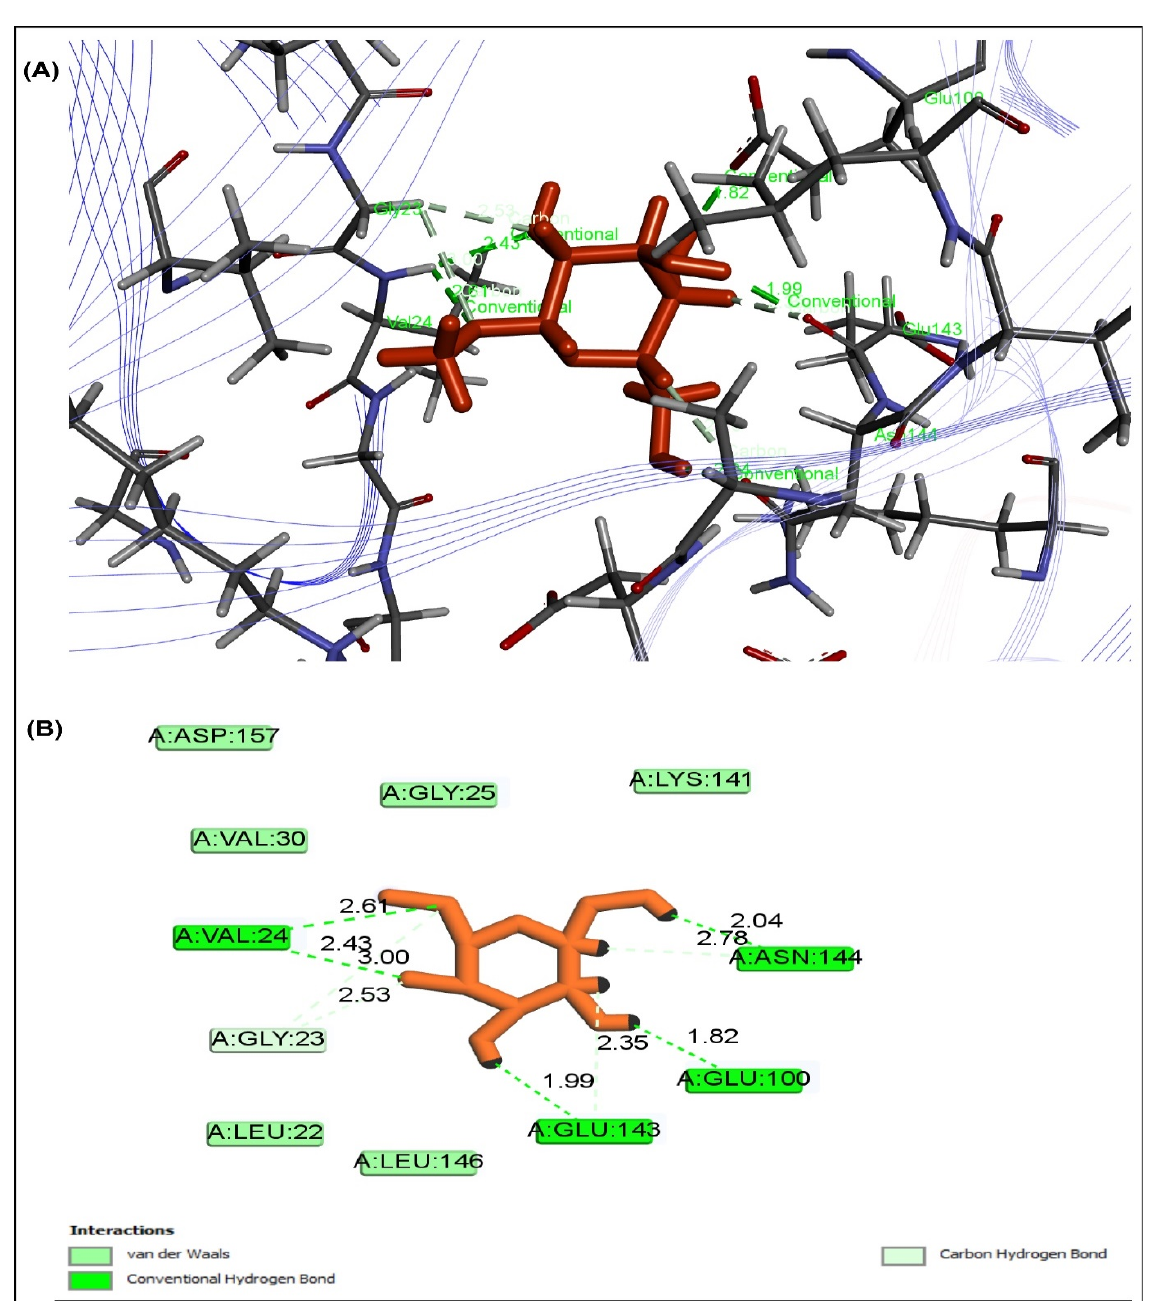
Figure 8. Docking study displayed that the highest rank poses of methyl α - D -galactopyranoside docked with the active site of AMPK for possible antidiabetic activity in ( A ) 2D and ( B ) 3D molecular interactions.